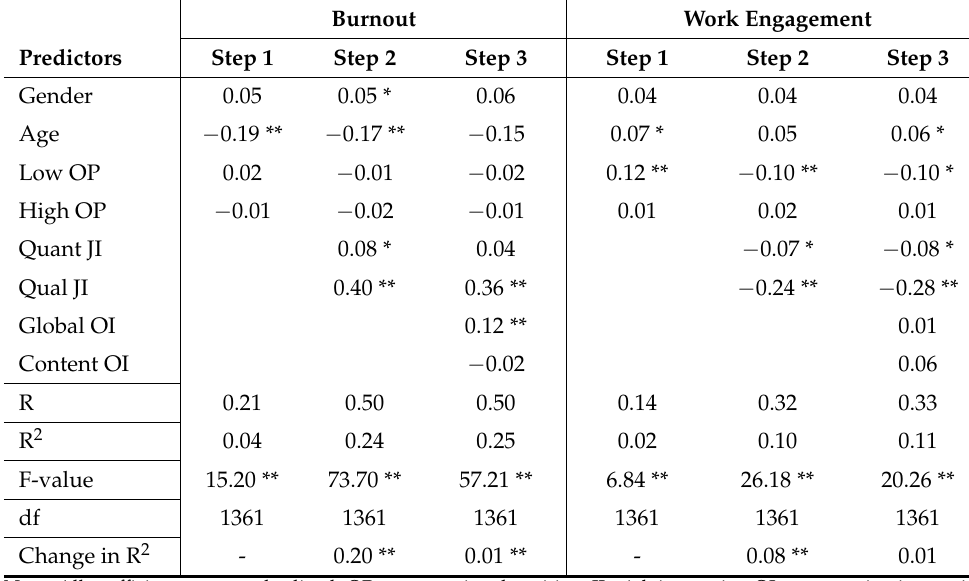
Table 5. Stepwise linear regression results to examine incremental validity.